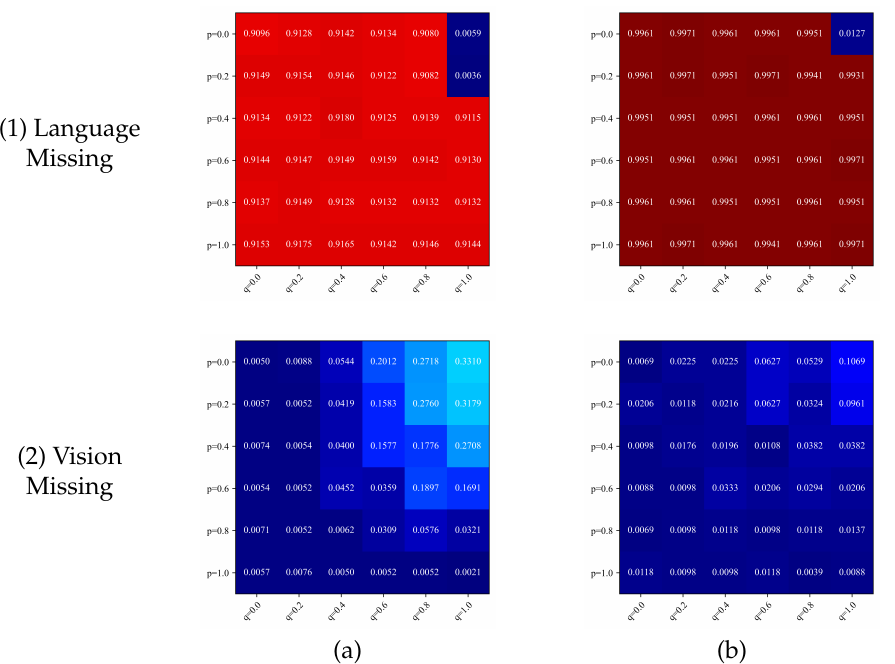
Figure 3. Heat map of accuracy of model facing modal missing for different values of p and q . ( a ) Birds. ( b )